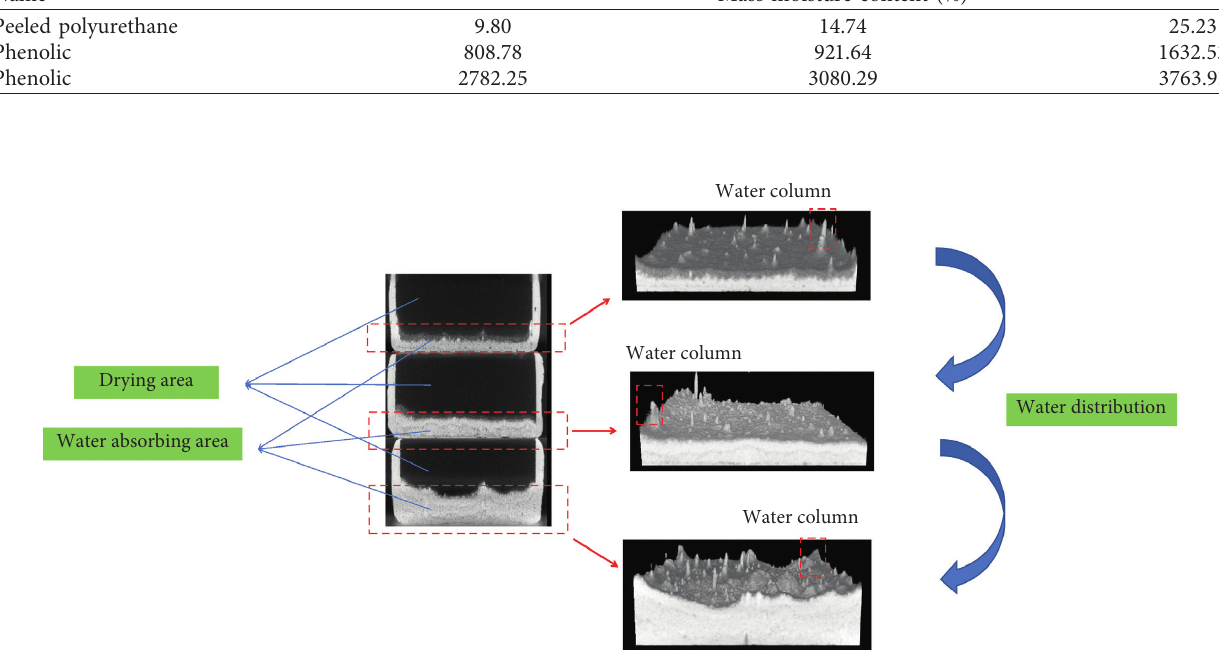
Figure 6: CT scanning image of the phenolic insulation plate sample in three directions.